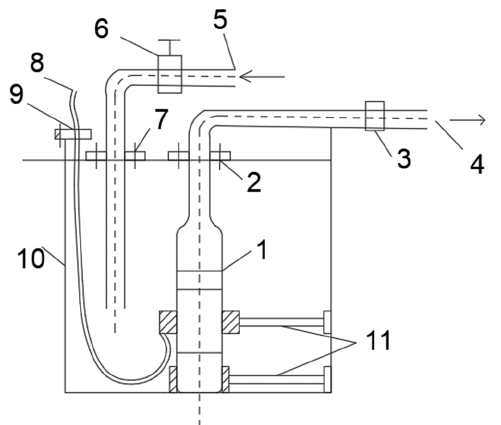
Figure 23. Test system diagram. 1—Test pump (including motor); 2—Test pump support mechanism; 3—Flow meter; 4—Outlet pipe; 5—Return pipe; 6—Regulating valve; 7—Return pipe support member; 8—Cable terminal; 9—Cable fixing component; 10—Water tank; 11—Anti-submersible pump swing component.